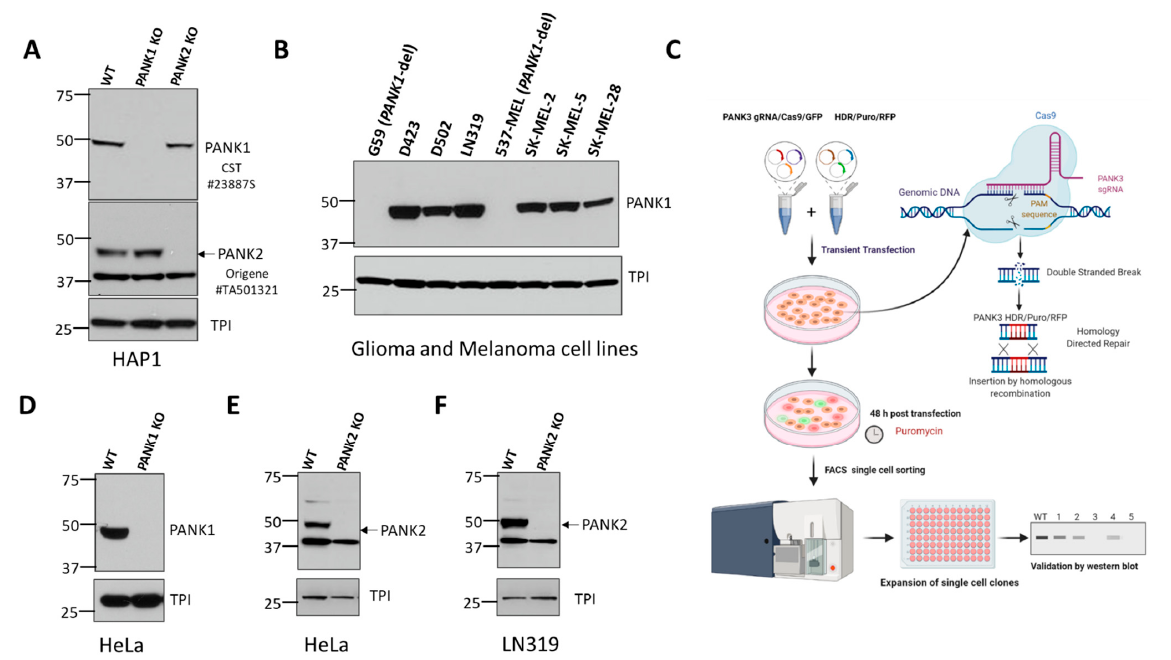
Figure 1. Validation of commercially available antibodies for PANK1 and PANK2. ( A ) Commer- cially obtained and genomically validated CRISPR knockout HAP1 cell lines were used as negative controls to verify the specificity of the PANK antibodies. Western blot confirming the loss of signal of PANK1 and loss of PANK2 in HAP1 PANK1 and PANK2 CRISPR knockout clones purchased from Horizon Discovery. Rabbit anti-PANK1 mAb from CST (#23887S) correctly identifies a single band at 50 kDa (expected molecular weight of PANK1 protein) in WT HAP1 cells, and the band is absent in the PANK1 KO CRISPR clone. Origene mouse anti-PANK2 (mAb#TA501321) identifies endogenous PANK2 protein in wild type HAP1 cells at the expected size of 48 kD, and the band disappears in the PANK2 CRISPR KO clone. A non-specific band at 37 kD is evident but is sufficiently distinct not to confound interpretation. Triose phosphate isomerase (TPI) was used as a loading control. ( B ) Validation of CST PANK1 antibody using the PANK1 deleted and PANK1 intact glioma and melanoma lines. G59 (glioma) and 537 MEL (melanoma) are PANK1 homozygous deleted cancer cell lines. ( C ) Schematic showing the Santa Cruz two-plasmid (gRNA/Cas9/GFP and HDR/Puromycin/RFP) system-mediated CRISPR KO. ( D – F ). Independent in-house generation of PANK1 and PANK2 CRISPR KO in cancer cells, and validation by Western